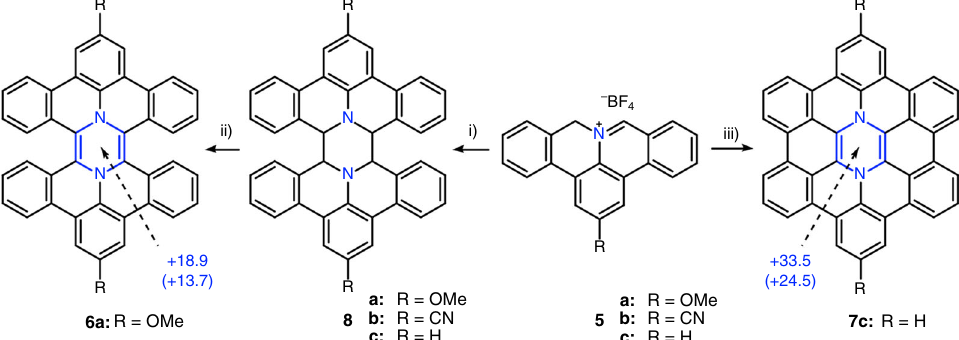
Fig. 2 Synthesis of diaza-HBP 6a in solution and internally N-doped diaza-HBC 7c upon interfacial con fi nement. Reagents and conditions: (i) tributylamine, DMSO, 190 °C; (ii) DDQ, C 2 D 2 Cl 4 , 100 °C; (iii) in vacuo on the Ag(111) surface, 270 °C. The calculated nucleus-independent chemical shifts (NICS) values are depicted in blue (unit: ppm), indicating the antiaromatic nature of the pyrazine ring (in parenthesis the NICS(1) value, see text and Supplementary Fig.